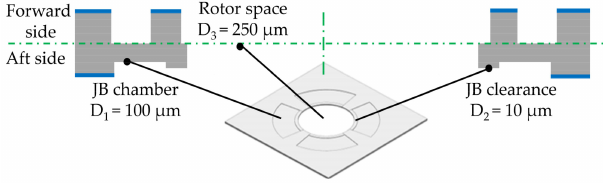
Figure 7. Cross section view of L2 layer with three depths on aft side.